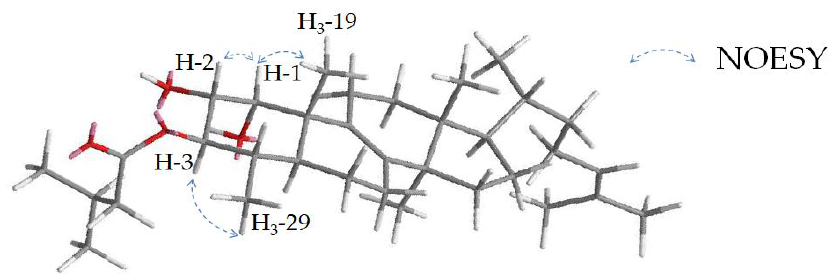
Figure 10. Key NOESY signals of 23 for determination of the relative configuration in the A ring.